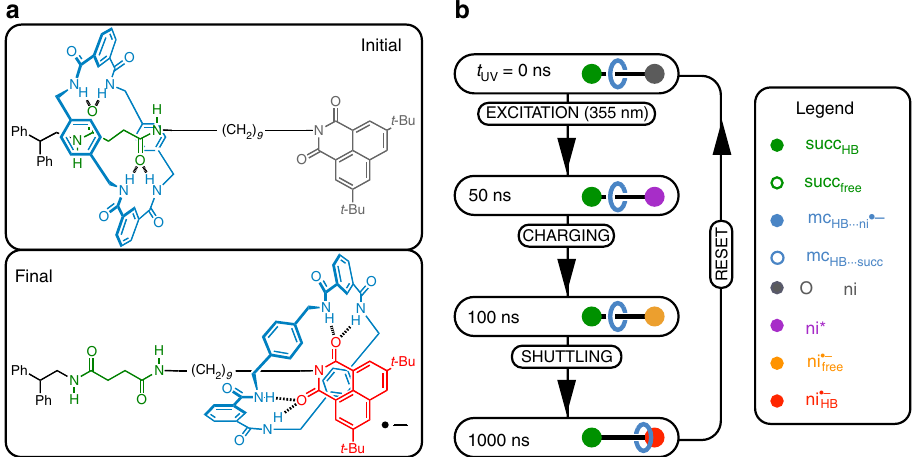
Fig. 1 Structure and operation cycle of the molecular shuttle. a Chemical structure of the molecular shuttle. b Photochemical operation cycle. The operation of the shuttle is initiated by a UV light pulse (EXCITATION), which causes a reduction of the ni * by an external electron donor (CHARGING). The subsequent translational motion of the macrocycle occurs between 100 and 1000 ns (SHUTTLING). The shuttle is RESET after charge recombination. The legend colours correspond to the coloured components of the molecular shuttle 2 NATURE COMMUNICATIONS | 8: 2206 | DOI: 10.1038/s41467-017-02278-6 |